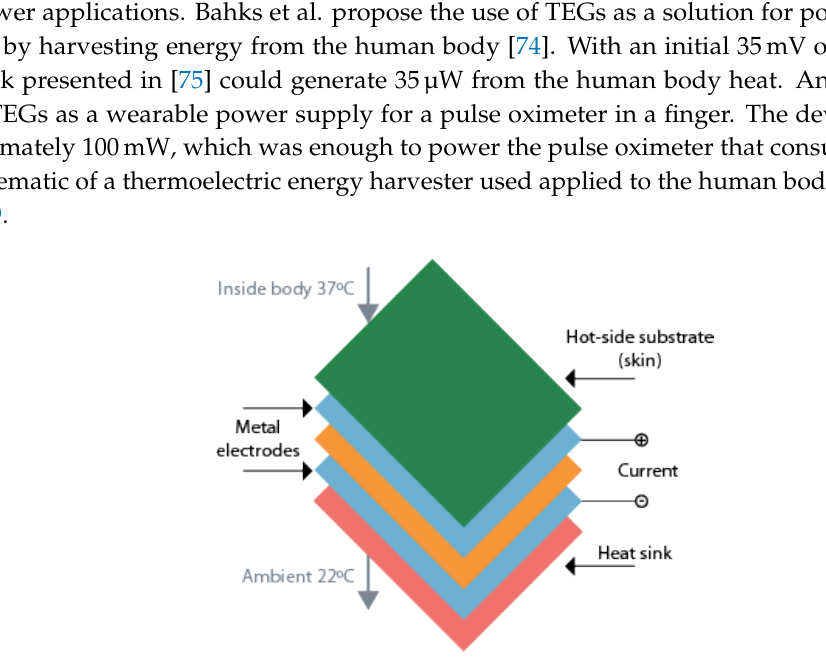
Figure 9. Schematic of a thermoelectric energy harvester applied to human body. Adapted from